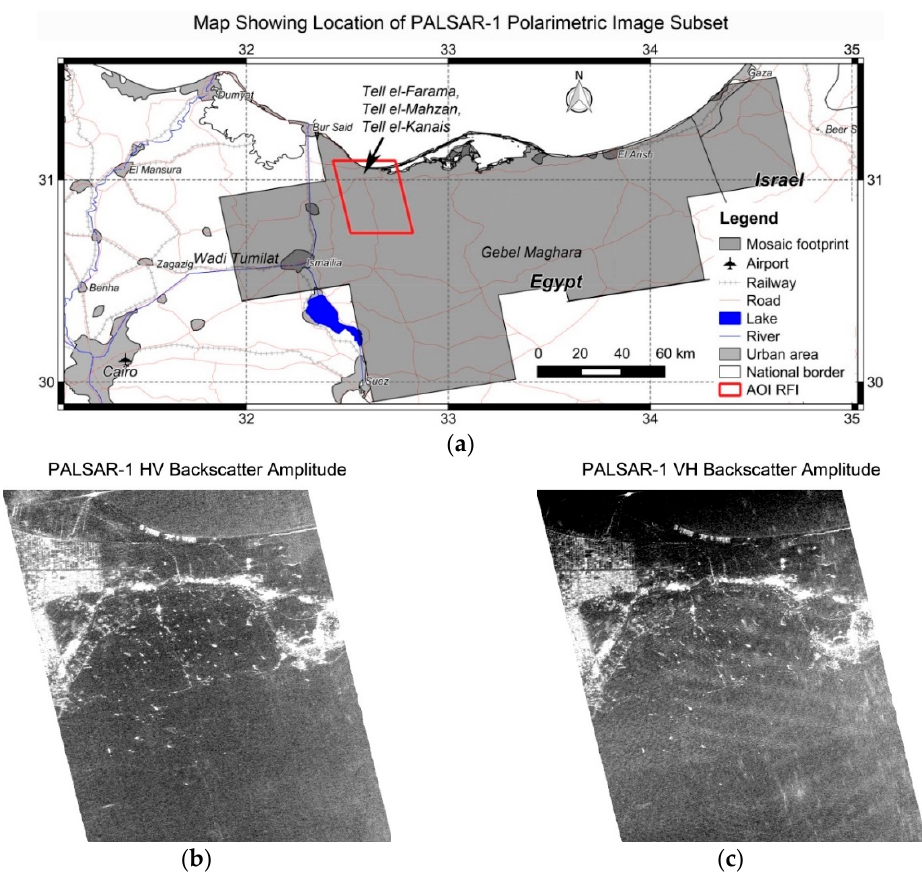
Figure 9. ( a ) Map showing subset region (as red polygon) where Radio Frequency Interference (RFI) has been detected on PALSAR-1 polarimetric data; ( b ) HV polarization backscatter amplitude of PALSAR-1 Polarimetric mode image subset acquired over area shown in ( a ), on 8 April 2009. The image has a pixel spacing of 25 m and has been geocoded to geographic latitude/longitude, WGS84. PALSAR-1 data provided by ESA; ( c ) VH polarization backscatter amplitude of same PALSAR-1 Polarimetric image subset as in ( b ). PALSAR-1 data provided by ESA.